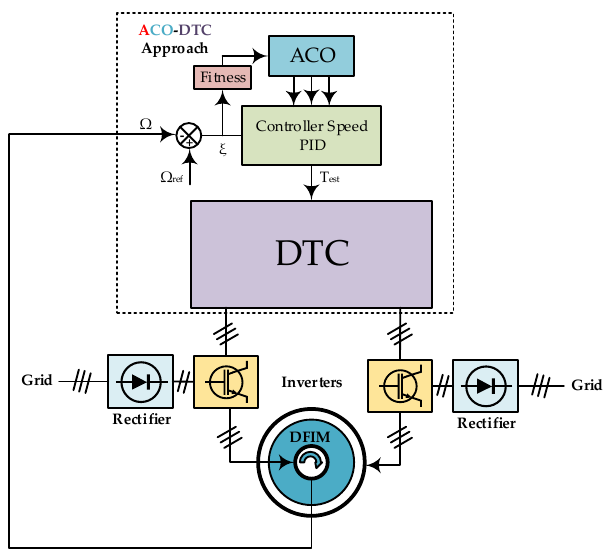
Figure 1. ACO-DTC control summary structure.